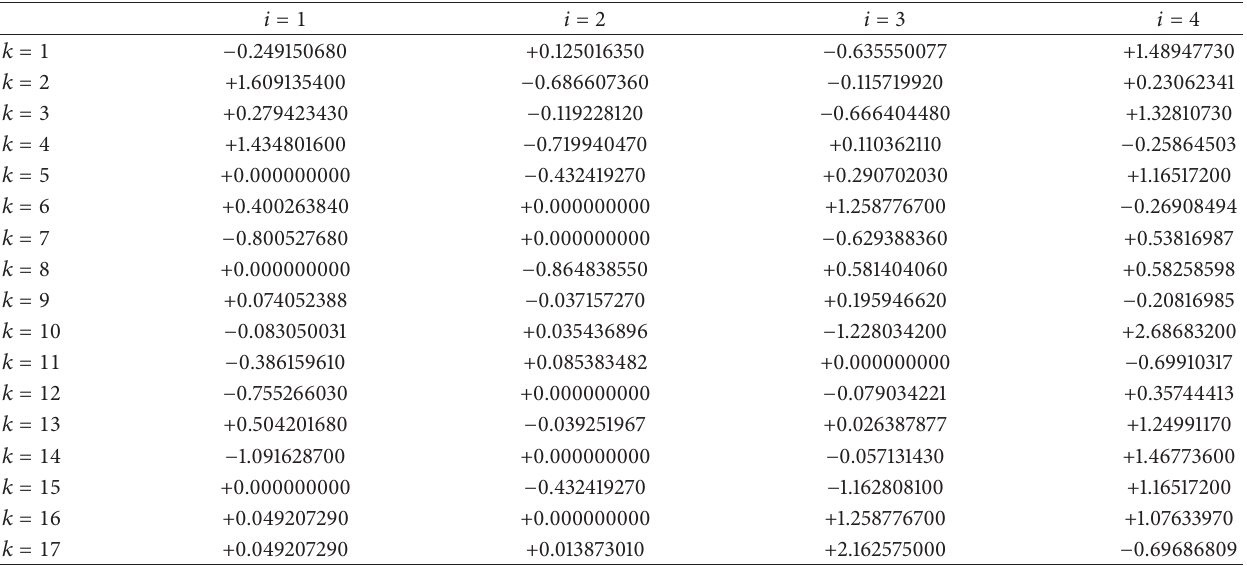
Table 1: Coefficients 𝑎 𝑘𝑖 for the kinematic application.